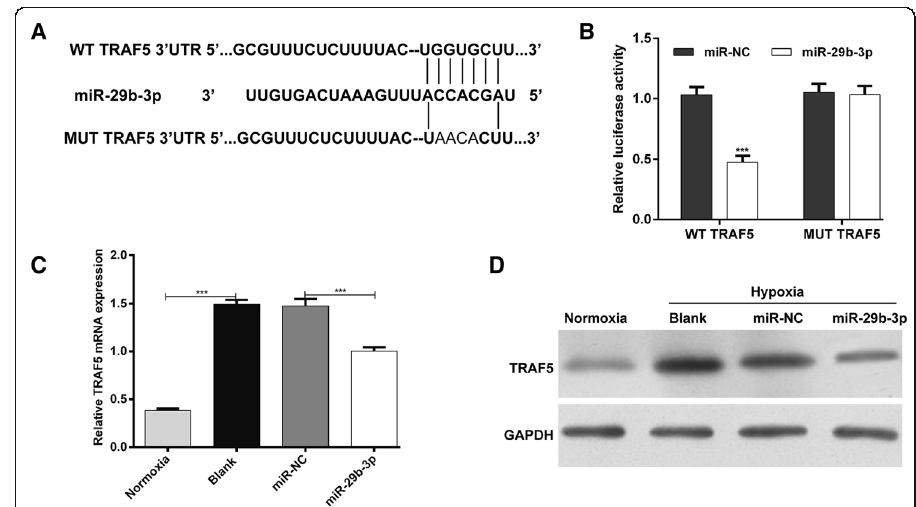
Fig. 3 MiR-29b-3p targets the 3 ’ UTR of TRAF5. a – The predicted miR-29b-3p-binding sites located in the 3 ’ UTR of TRAF5. b – The effect of miR-29b-3p on luciferase activity was detected using the dual-luciferase reporter assay. The pmirGLO reporter vector containing the WT or MUT TRAF5 was co-transfected with miR- 29b-3p or miR-NC into AC16 cells for 48 h. c and d – The mRNA and protein expressions of TRAF5 in AC16 cells transfected with miR-29b-3p or miR-NC and then subjected to hypoxia for 24 h were determined using quantitative real time PCR and western blot analysis. Each experiment was repeated three times. *** p <